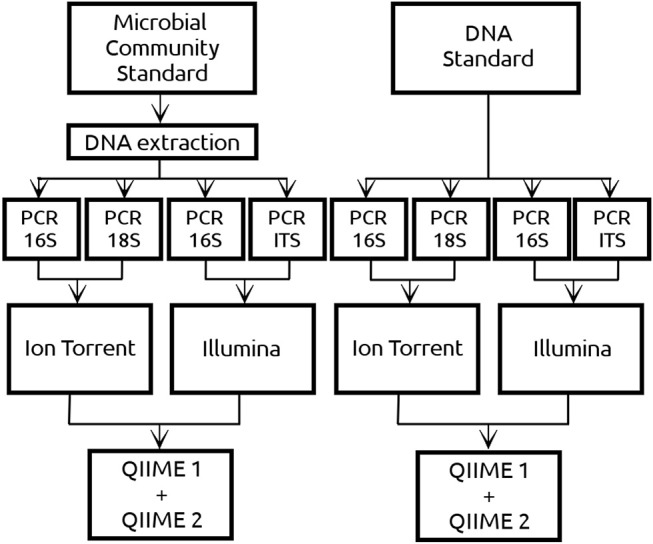
Two commercial mock community standards from ZymoBIOMICS™ with exactly the same microbial composition of 8 prokaryotes and 2 eukaryotes have been used in the current study. The Microbial Community standard (referred as CS) consisted of microbial cells from which DNA was extracted using an in-house DNA extraction protocol. The DNA standard (referred as DS) contained DNA from the same 10 microbial cells as the CS but extracted by ZymoBIOMICS™. Both standards were sequenced using Ion Torrent and Illumina platforms. Regarding the DNA from the prokaryotic cells, both platforms sequenced the 16S amplicon. Regarding the DNA from the eukaryotic cells, Ion Torrent sequenced the 18S amplicon whereas Illumina the ITS amplicon. In the case of Ion Torrent 30 and 45 PCR cycles have been implemented in both amplicons, whereas in Illumina only 30 PCR cycles were implemented. Sequencing data derived from both NGS platforms have been analyzed using QIIME 1 and QIIME 2.